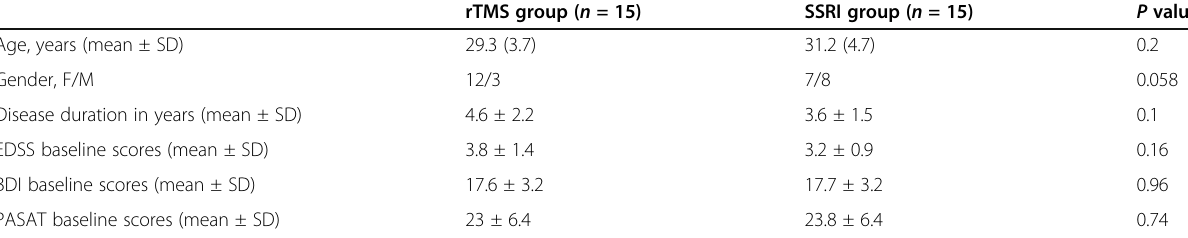
Table 1 Demographics and baseline clinical characteristics of the study